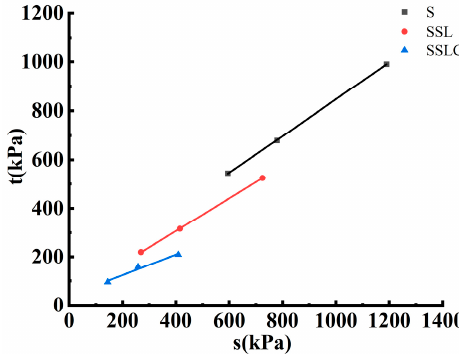
Figure 9. The stress-strain curves at different confining pressures: ( a ) 50 MPa; ( b ) 100 MPa; ( c ) 200 MPa.